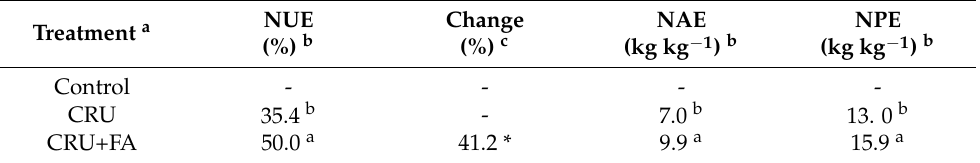
Table 2. Fertilizer use efficiency of wheat under with different